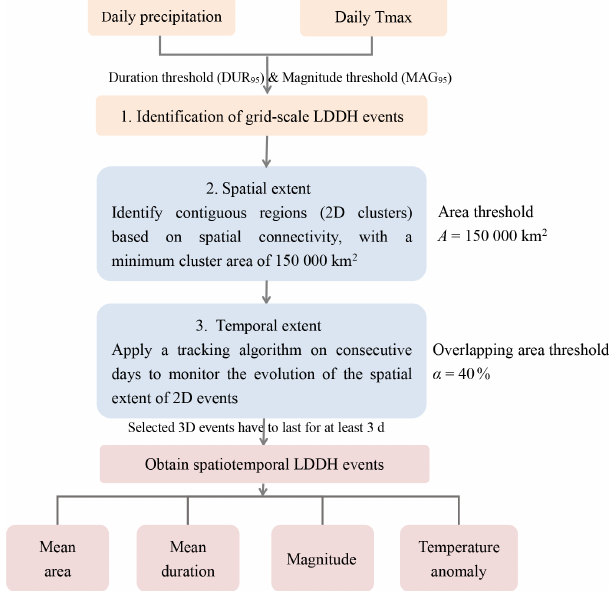
Figure 1. Flow chart for the identification of spatiotemporal com- pound long-duration dry and hot